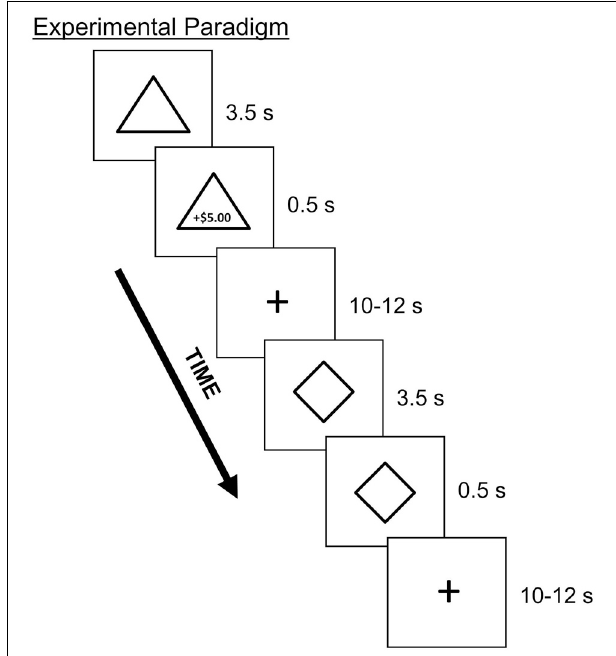
FIGURE 2 | Depiction of the Pavlovian conditioning task with partial reinforcement. On each trial, participants viewed a geometric shape (CS; e.g., triangle, diamond) that was paired with a monetary outcome (US; e.g., $5.00 gain) 50% of the time. Stimuli consisted of four different shapes, each paired with a specific monetary outcome that varied with respect to valence and